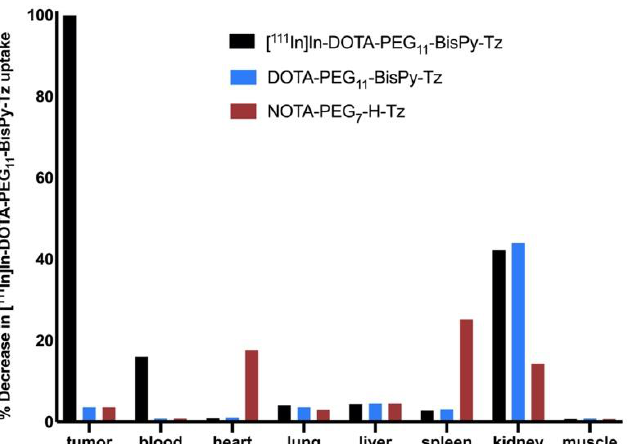
Figure 2 . Blocking study of NOTA-PEG 7 -H-Tz and DOTA-PEG 11 -BisPy-Tz. The tissue uptakes are normalized to the average tumor uptake of [ 111 In]In-DOTA-PEG 11 -BisPy-Tz ( 2 ). Tumor-bearing mice ( n = 3/group) were injected with CC49-TCO, 72 h before administration of the unlabeled tetrazines. After one hour, [ 111 In]In-DOTA-PEG 11 -BisPy-Tz ( 2 ) was administered. Ex vivo biodistribution were performed 22 h post [ 111 In]In-DOTA-PEG 11 -BisPy-Tz ( 2 ) injection.